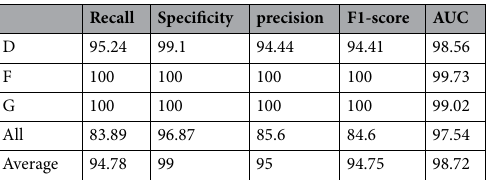
Table 5. Average performance of the proposed method for different breast tissue types.